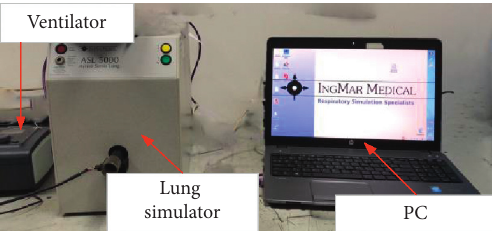
Figure 5: Experimental prototype. The experimental prototype consists of a lung simulator, a ventilator, and a